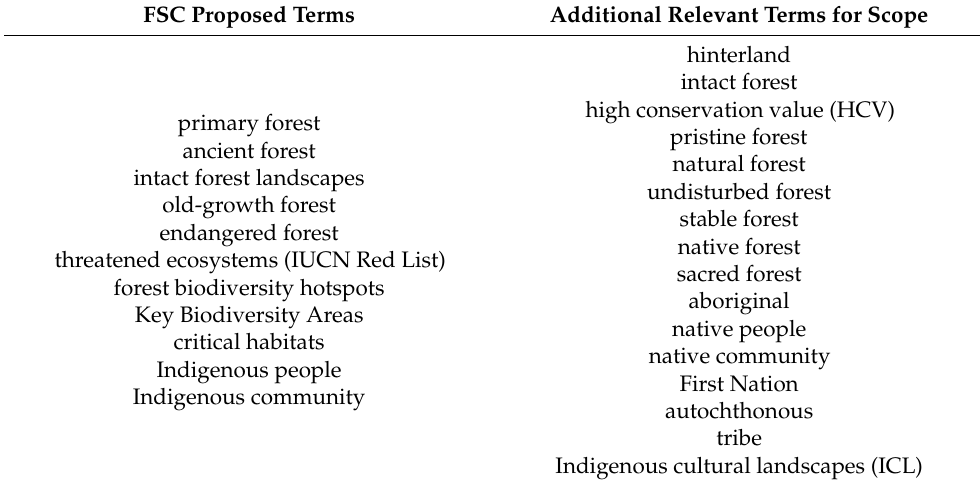
Table 2. Keywords considered in this study. All the listed terms with the ending ‘forest’ will also be searched with the alternate ending